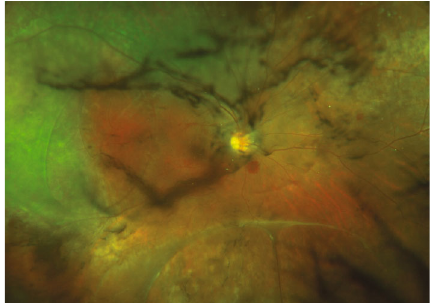
Figure 1: Wide fi eld fundus photo of the right eye demonstrating intravitreal hemorrhage, vitreous debris, scattered intraretinal hemorrhage in the macula, and multiple areas of retinoschisis.